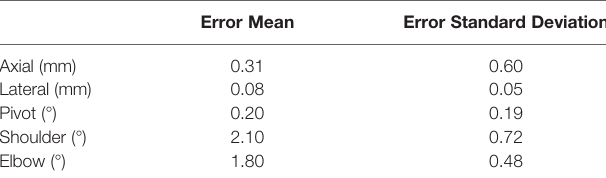
TABLE 3 | Measured joint level errors.